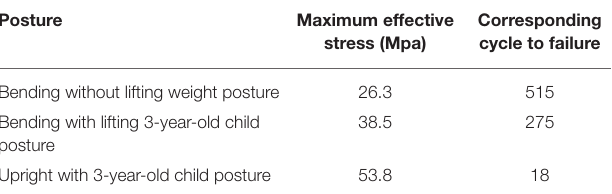
TABLE 1 | The corresponding cycle to failure of three postures were deduced from the effective stress according to the cycle number to failure vs. the stress curve. Posture Maximum effective Corresponding stress (Mpa) cycle to failure Bending without lifting weight posture